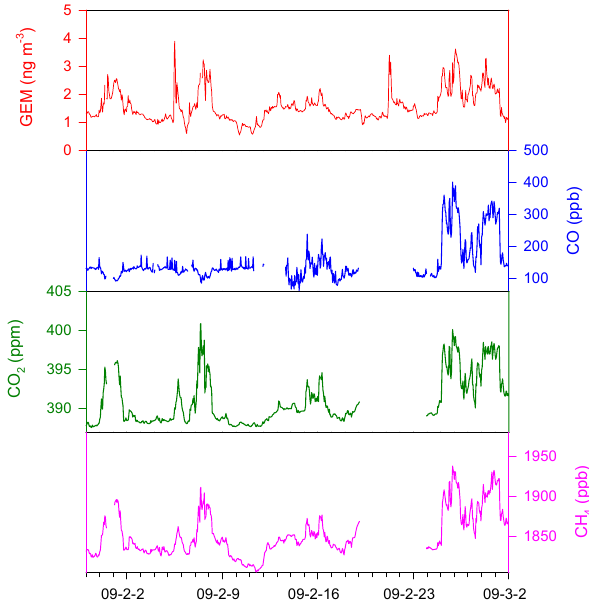
Figure 2. A typical example of the consistent variations in GEM, CO, CO 2 , and CH 4 for the period of 30 January to 2 March 2009 at Mt. Waliguan